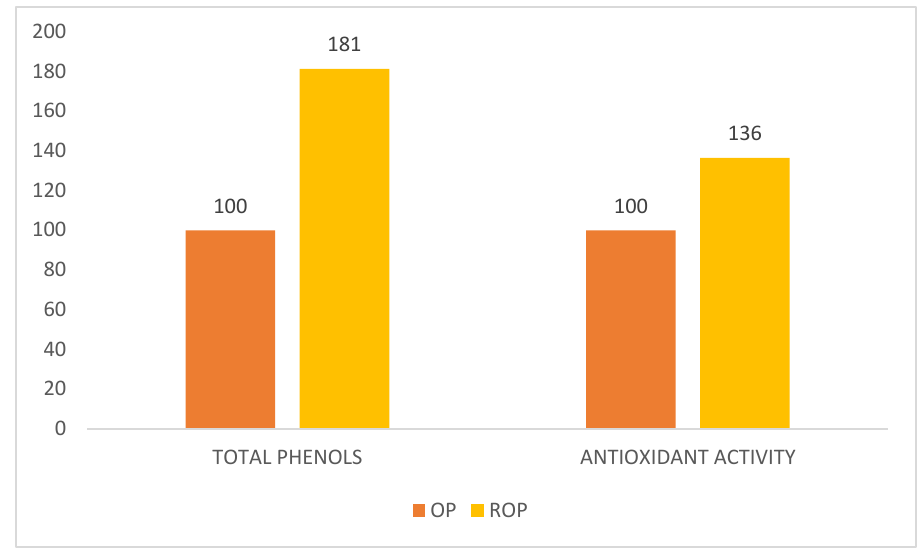
Figure 3. Comparison of the reinforcement effects (OP = 100).